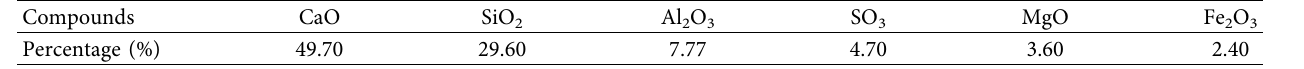
Table 1: The main chemical composition of the